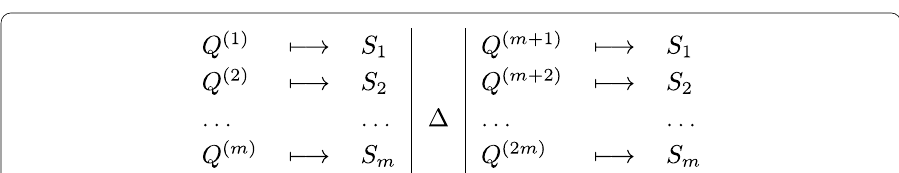
Fig. 3 Use of 2 m realizations of an isomorphic question for individualized repeat assessment of students S i , i = 1,...,